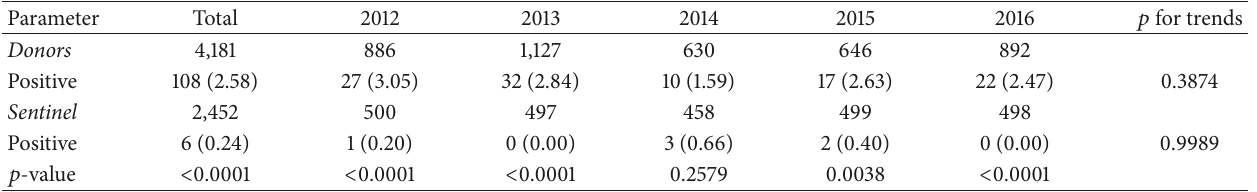
Table 2: Year-on-year prevalence of Syphilis infection among blood donors and pregnant women in the Ho municipality. Parameter